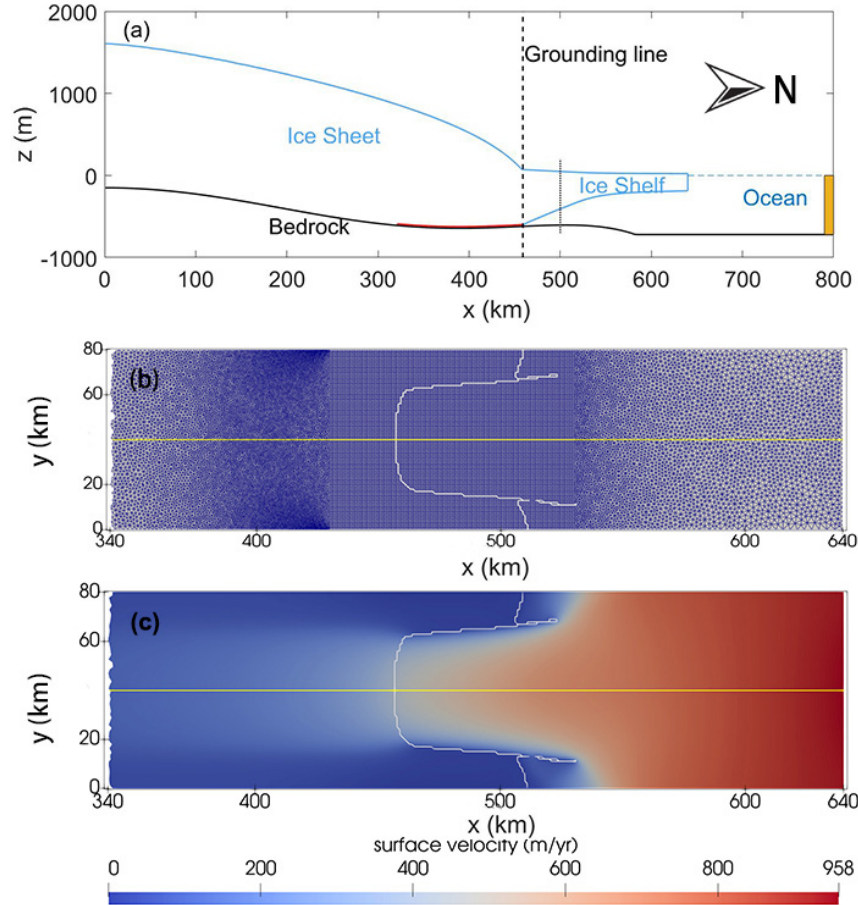
Figure 2. Schematic of the initial geometry. (a) The geometry profile in the xz plane along the central flow line (yellow line in panel b ). The red line is the zone where the wet–dry cells are dry (see Sect. 2.5 for details). The yellow filled area is the restoring region. (b) The mesh of the ice model in the xy plane, with the grounding line shown as the white line. (c) Magnitude of surface velocity in the xy